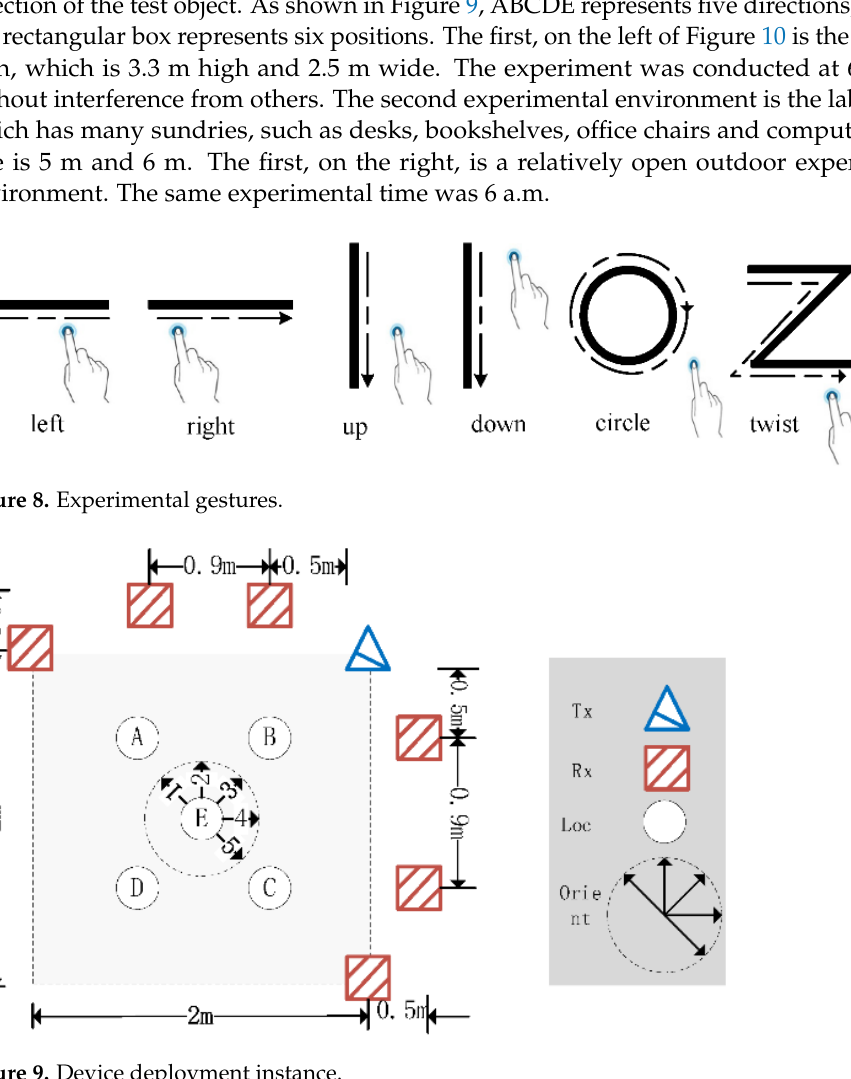
Figure 9. Device deployment instance.